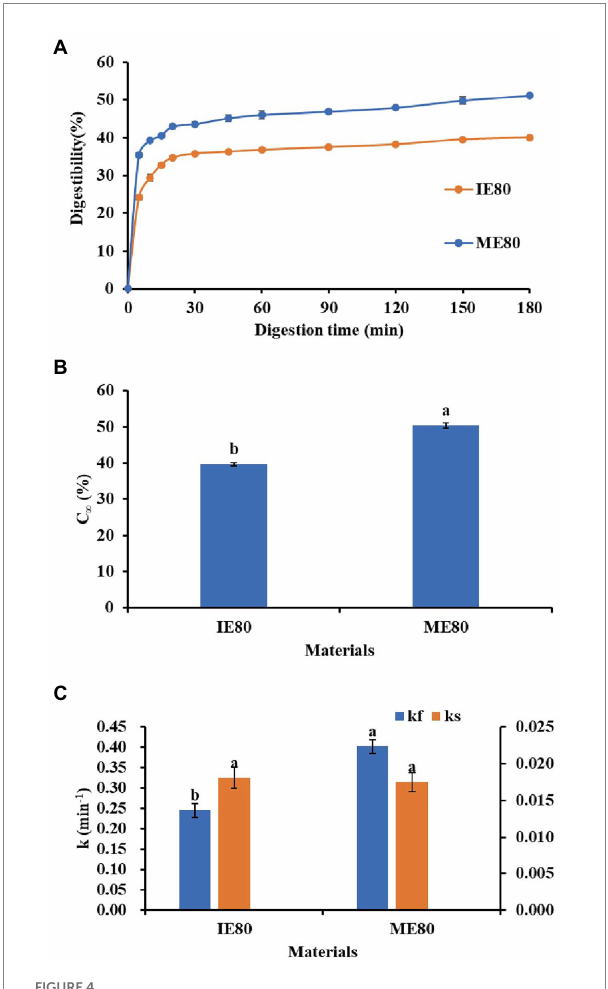
FIGURE 4 In vitro hydrolysis curves (A) and digestibility parameters C and k s (C) from LOS plot of different instant powder samples. k f , starch digestion rate constants for the fast step; k s , starch digestion rate constants for the slow step; C digested at the reaction end